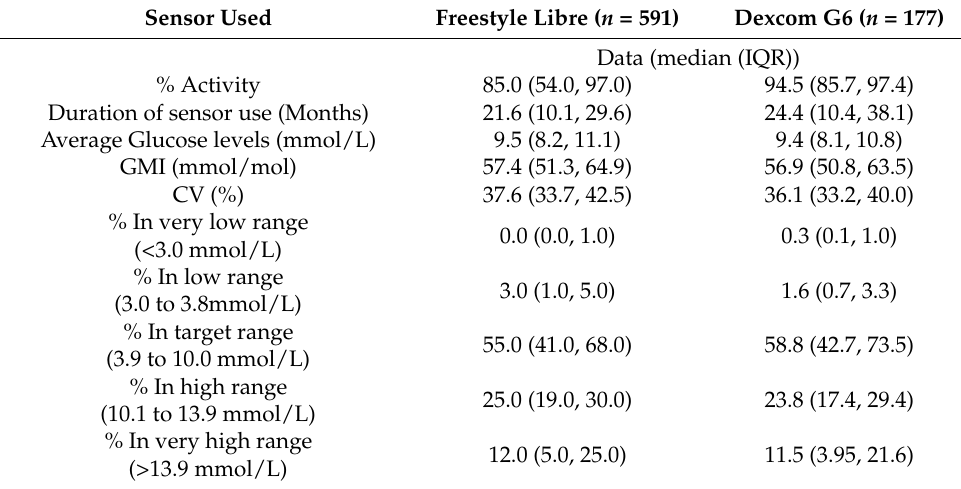
Table 3. Summary of sensor-based metrics for people with type 1 diabetes using FSL and Dexcom G6 sensors.